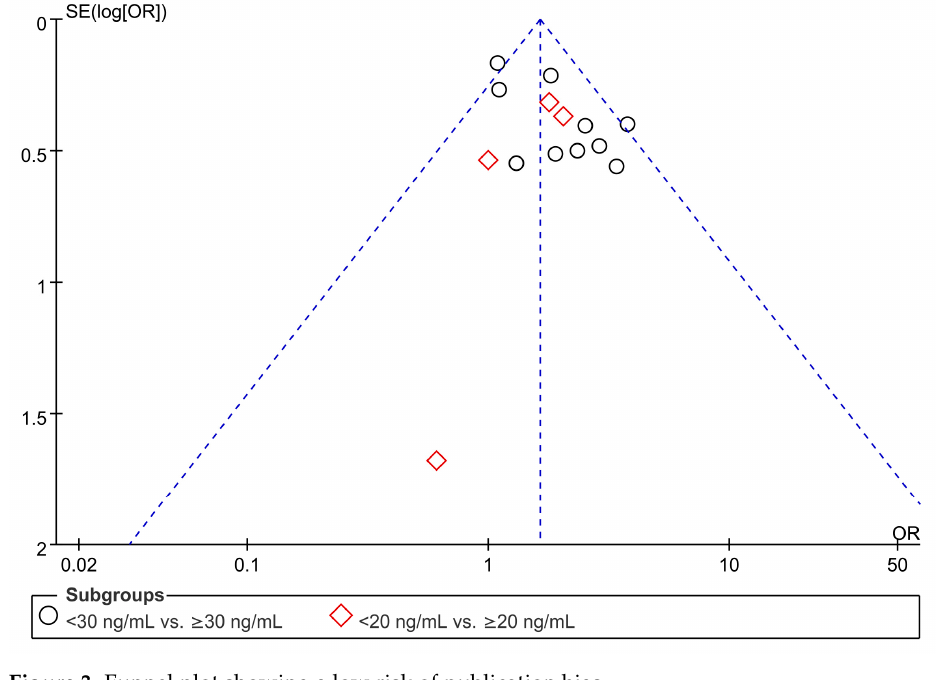
Figure 3. Funnel plot showing a low risk of publication bias.